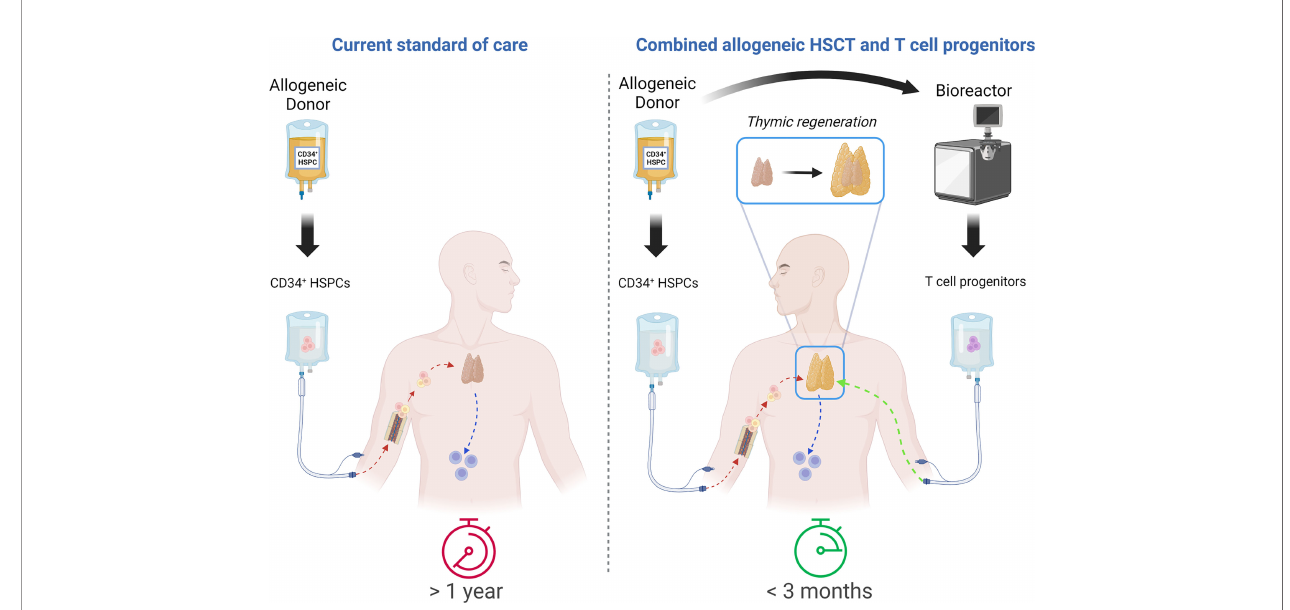
FIGURE 1 | Comparative approach between allo-HSCT as a current standard of care and combination of allo-HSCT with T-cell progenitor transplantation. Timing of fully functional T-cell compartment reconstitution: more than 1 year with current standard of care vs. less than 3 months with combinatorial approach. Created with